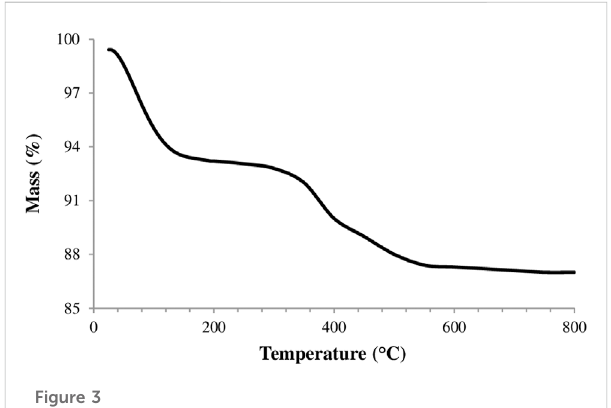
Figure 3 TGA thermogram of natural clay